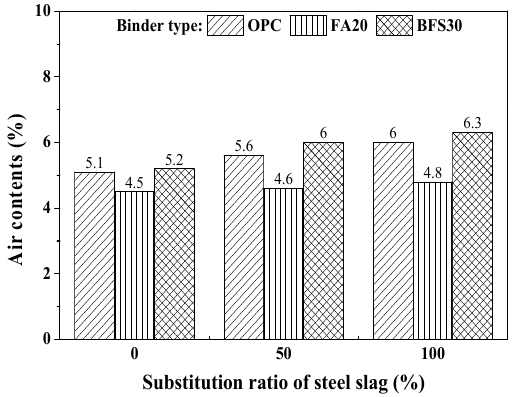
Figure 4. Results of air contents test.